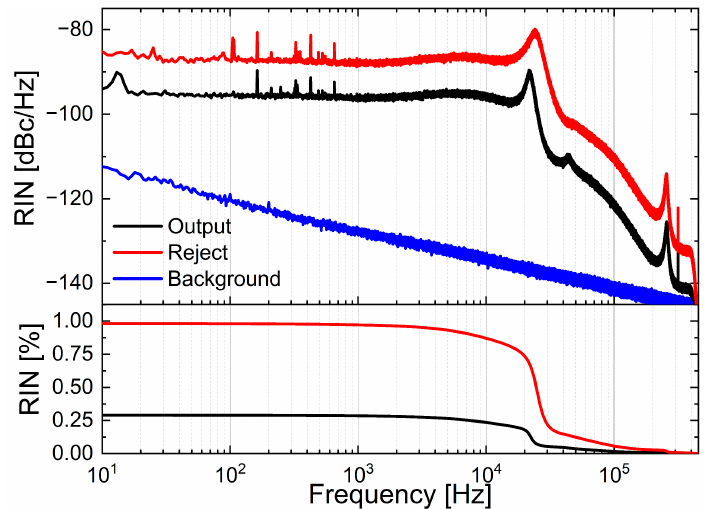
Figure 3. Relative intensity noise characterization for both exit ports. Upper panel: RIN results; lower panel: integrated RIN.